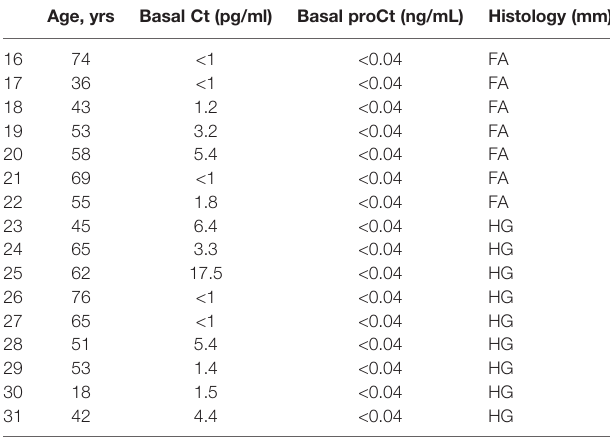
TABLE 2 | Clinical features of the patients retrospectively collected from University of Padua tissue bank submitted to thyroid surgery for non-C-cell thyroid nodular